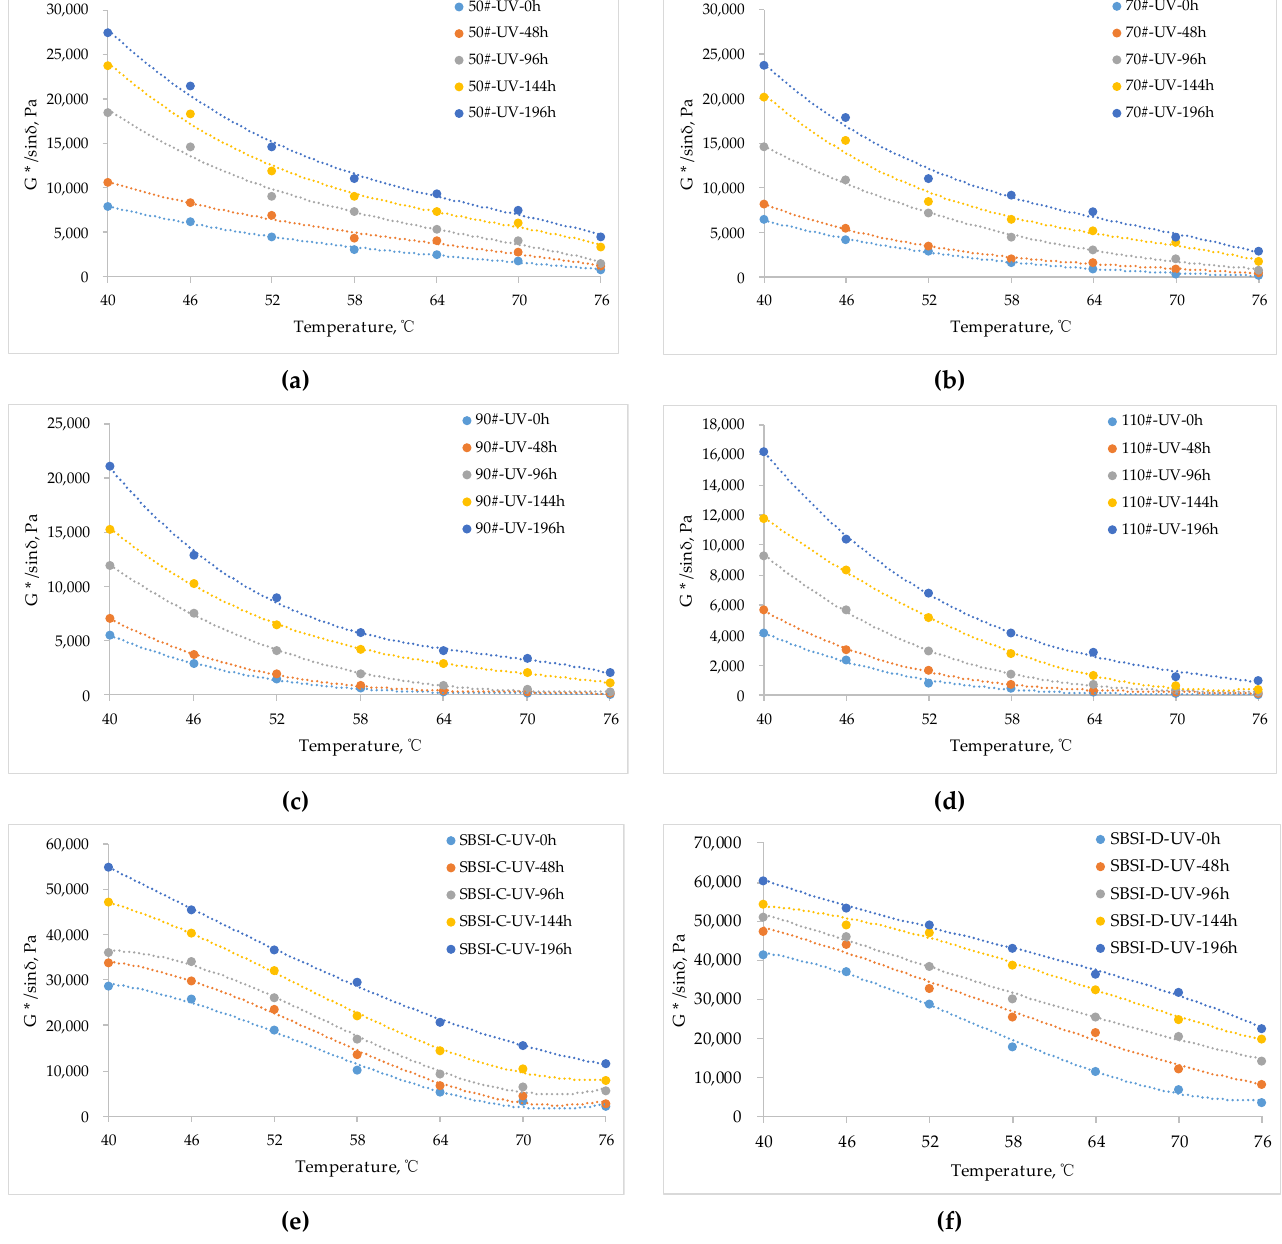
Figure 12. G*/sinδ of different asphalts under different UV irradiation times and temperatures: ( a ) 50 # ; ( b ) 70 # ; ( c ) 90 # ; ( d ) 110 # ; ( e ) SBS I-C; ( f ) SBS I-D.